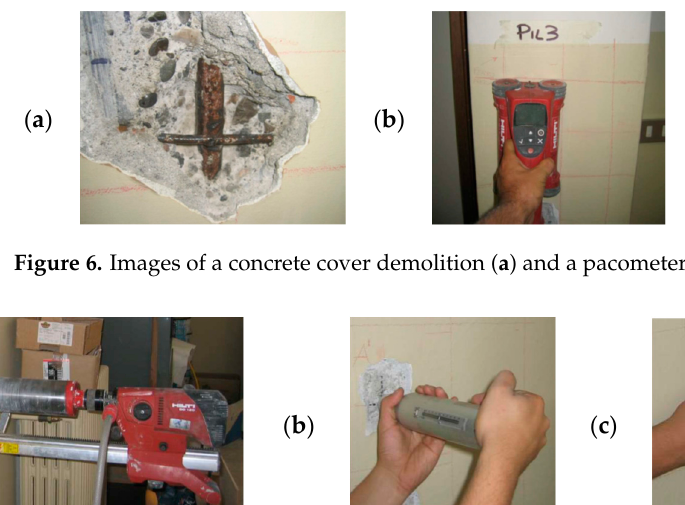
Figure 7c—tests) for concrete.